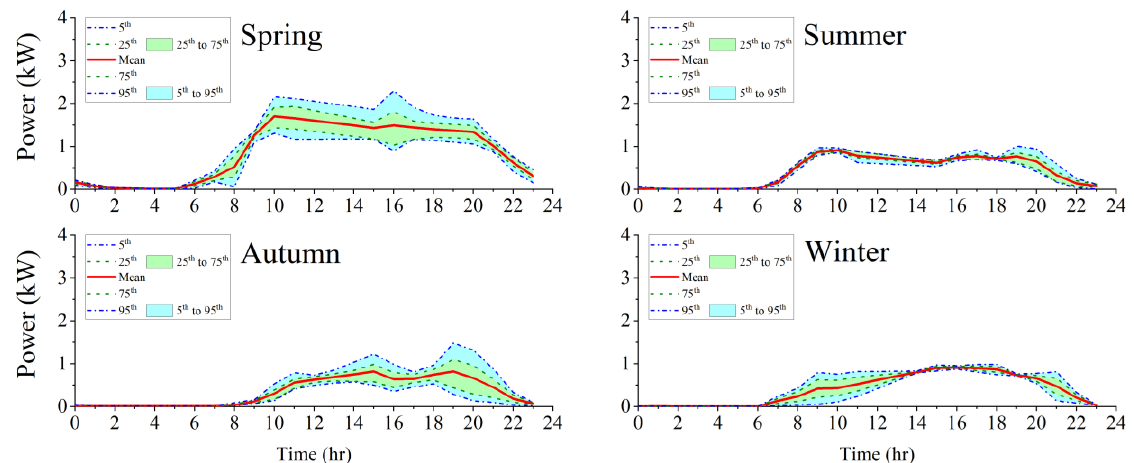
Figure 18. Average annual and seasonal EV charging station daily load profiles (with percentile ranges).